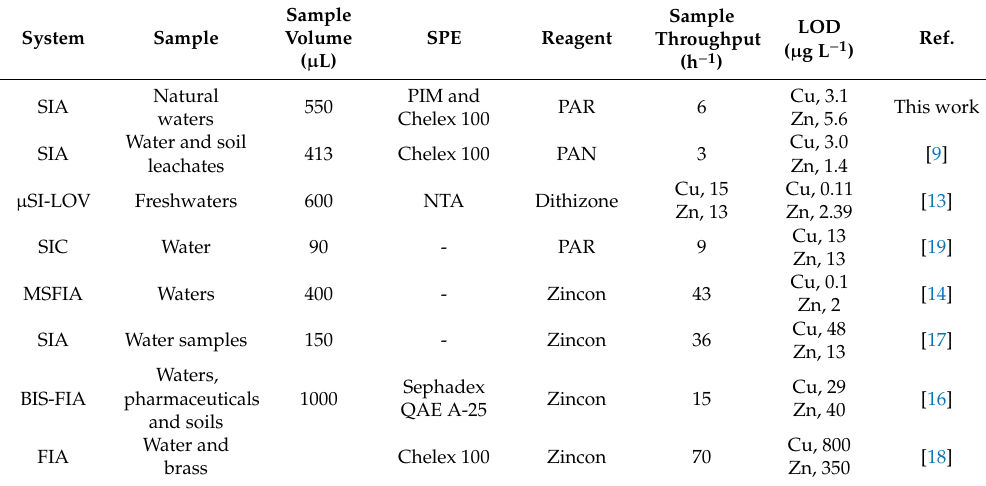
Analytical features of flow-based systems developed for copper(II) and zinc(II) spectrophotometric determination in water samples (presented in descending chronological